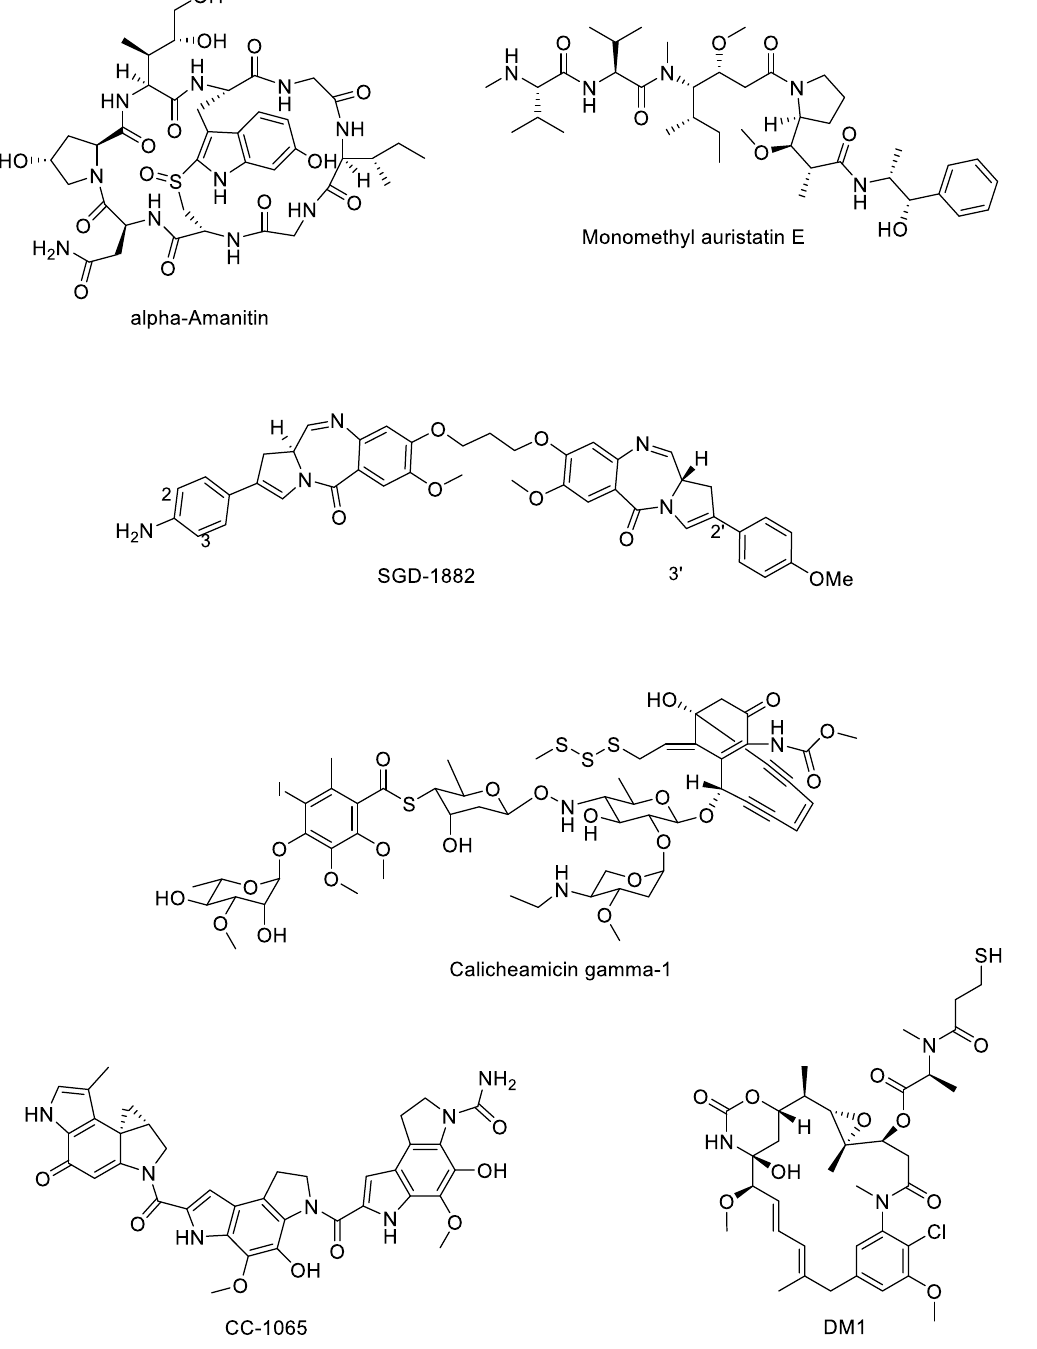
Figure 4. Structures of representative members of the various payload classes used in ADCs.